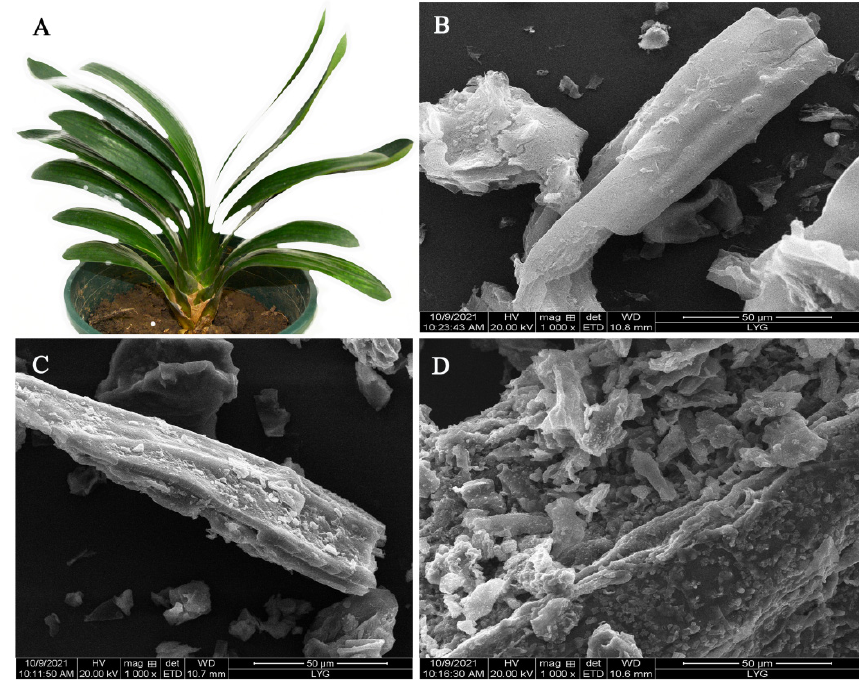
Figure 1. ( A ) A digital photo of CM and SEM images of ( B ) CM, ( C ) CCM, and ( D )